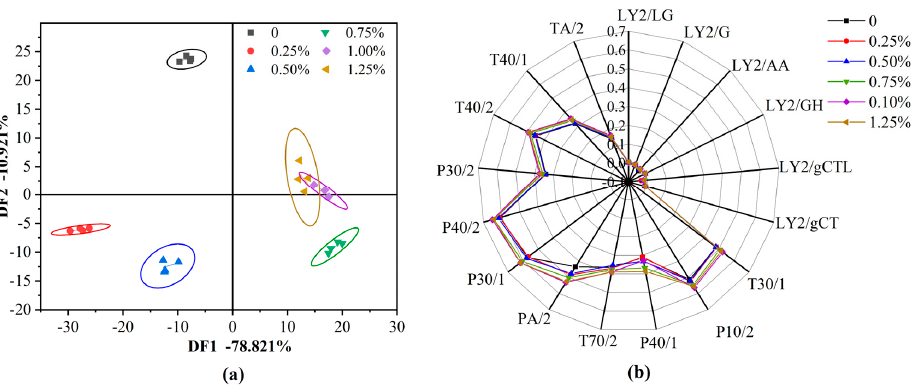
Figure 4. Discriminant factor (DF) analysis chart ( a ) and radar chart ( b ) of the extrudates with the different addition of cysteine.